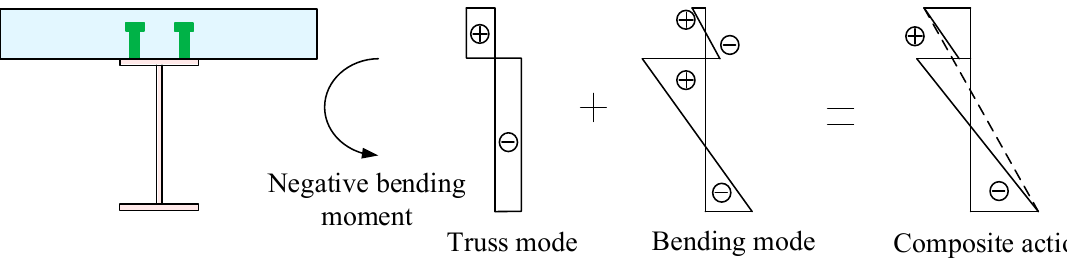
Figure 2. Stress and strain analysis of a composite beam section under hogging moment.